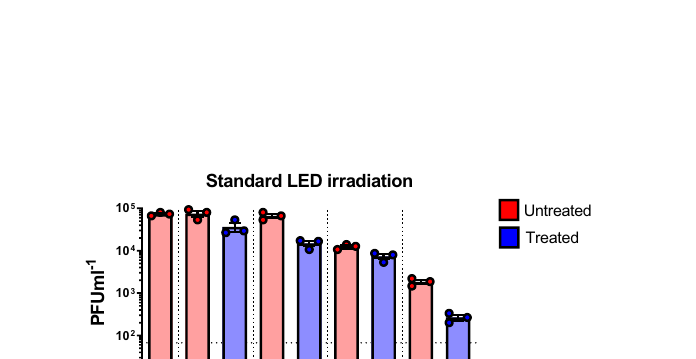
Figure 4. Encephalomyocarditis virus (EMCV) in PBS shows reduced susceptibility to 405 nm irradiation. ( A ) A dose of 0.6 mW cm −2 was applied to irradiate samples at 405 nm over a course 8 h while sampling at 1, 2, 4 and 8 h (done in independent triplicates). Blue bars indicate treated samples and red bars correspond to the untreated equivalent that was left at the biosafety cabinet under the same conditions while not subjected to disinfecting irradiation. Data shown as PFUml −1 in triplicate assessed by plaque assay. ( B ) Plaque phenotype comparison from one independent experiment at an irradiation dose of 0.6 mW cm −2 . Fixed and blocked plaques were stained using crystal violet. Data show in here are from three independent replicates (Mean + SEM).